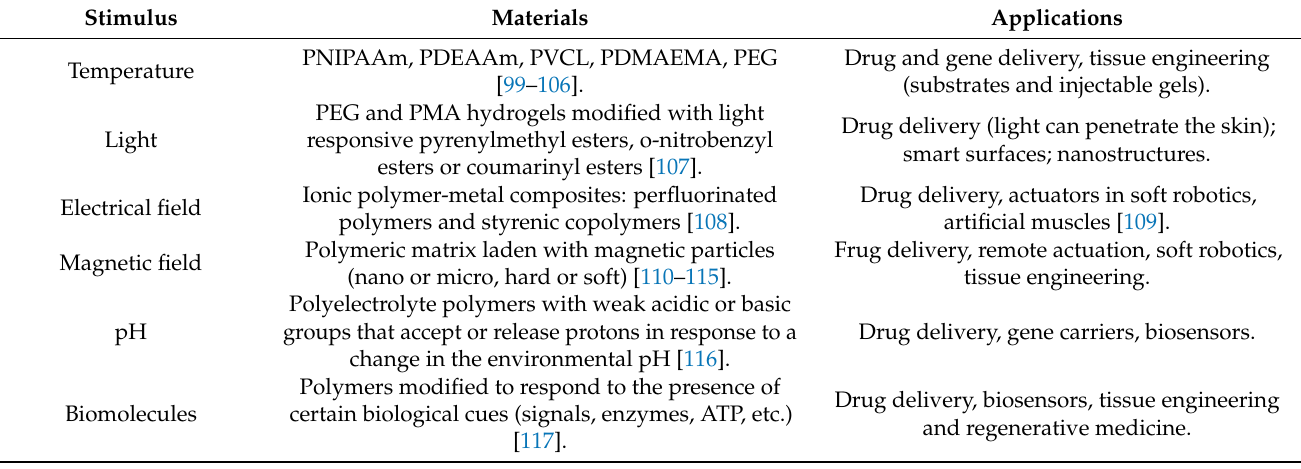
Table 1. Summary of multifunctional materials according to the nature of their stimulation and highlighting of applications. Stimulus Materials Applications Temperature